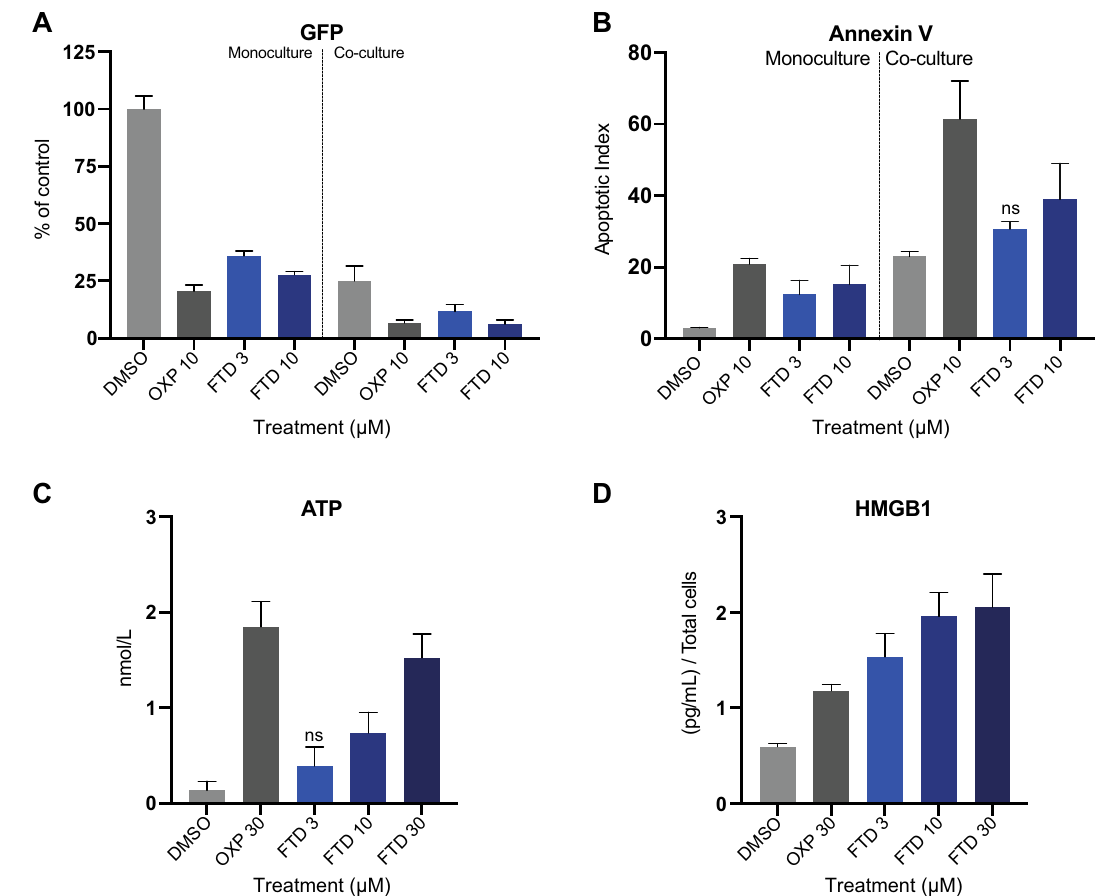
Figure 1. Trifluridine decreases viability and increases release of ICD markers in vitro. ( A ) Viability indirectly measured by image based GFP quantification (n = 9) and ( B ) Apoptotic Index determined by Annexin V (number of Annexin V positive cells/number of GFP expressing cells) (n = 6) in HCT116-GFP monoculture and co-culture with human PBMCs, treated with DMSO vehicle (0.1%), oxaliplatin (OXP) (10 μM), or trifluridine (FTD) (3, 10 μM) for 72 h. ( C ) ATP measured by CellTiter Glo in supernatants of HCT116-GFP monoculture treated for 48 h (n = 6) and ( D ) HMGB1 measured by ELISA in supernatants of HCT116-GFP monoculture treated for 72 h. Data normalized against total number of cells per sample. Results are shown as mean ± SD from two ( B – D ) or three ( A ) independent experiments. Compared to DMSO vehicle, P ≤ 0.05 (One-way Anova with Dunnett’s multiple comparison test) for all treatment data sets except the ones marked ns, not